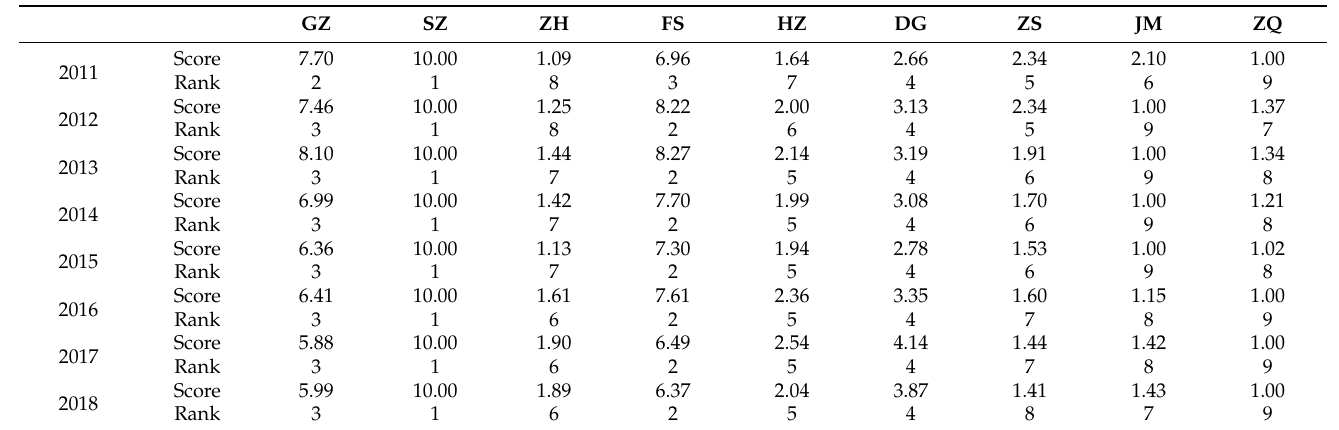
Table 3. Evaluation scores of the economic factor.